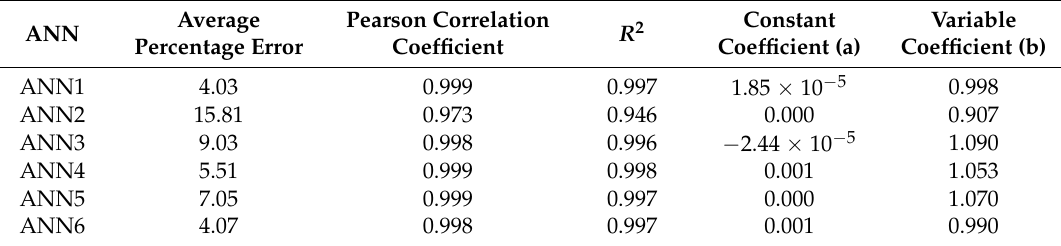
Figure 10. Comparison between the actual and predicted electricity consumption for the training results of ANN6 for a typical day in four seasons: ( a ) winter; ( b ) spring; ( c ) summer; and ( d ) autumn. Table 7. Training error analysis of each proposed ANN